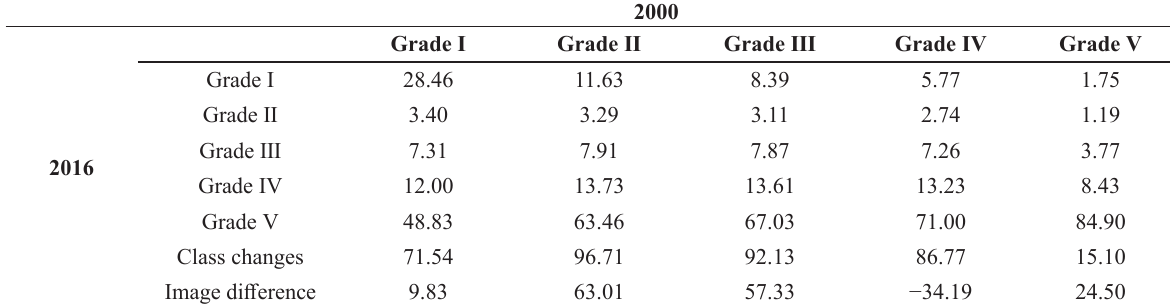
Grade transfer matrix of vegetation coverage from 2000 to 2016